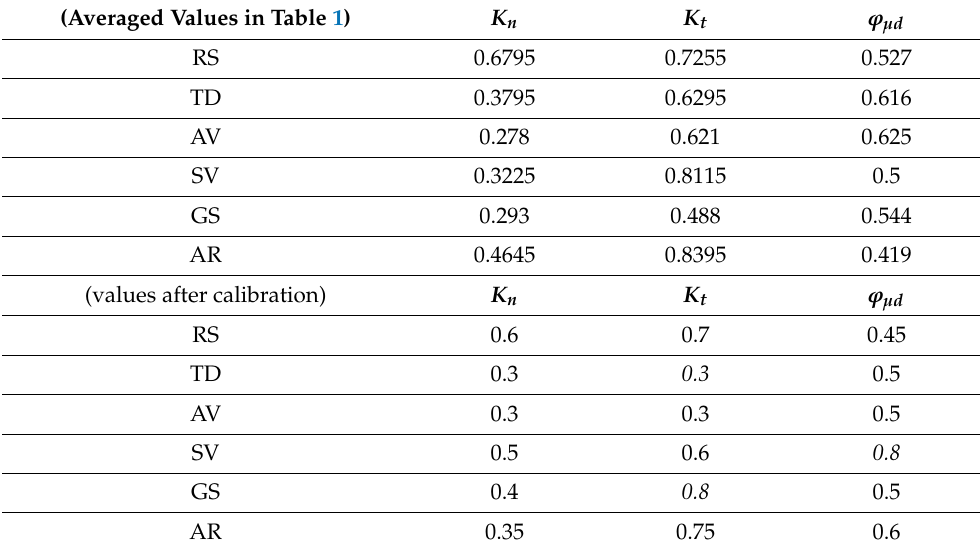
Figure 7. ( a ) Selection of rock blocks falling within a 5 m-buffer distance around arrest points foreseen by the model. Legend: W, L = width and length of accumulation area; ( b ) rock blocks inventory map and arrest points contour lines (expressed as ppm/m 2 ). Table 2. Kinematic parameters Kn , Kt and ϕ µ d before and after calibration (main variations in italics). Legend: RS = Rock slope; TD = Talus Deposits; AV = Arboreal Vegetation; SV = Shrub-like Vegetation; GS = Grass-covered Soil; AR = Asphalt